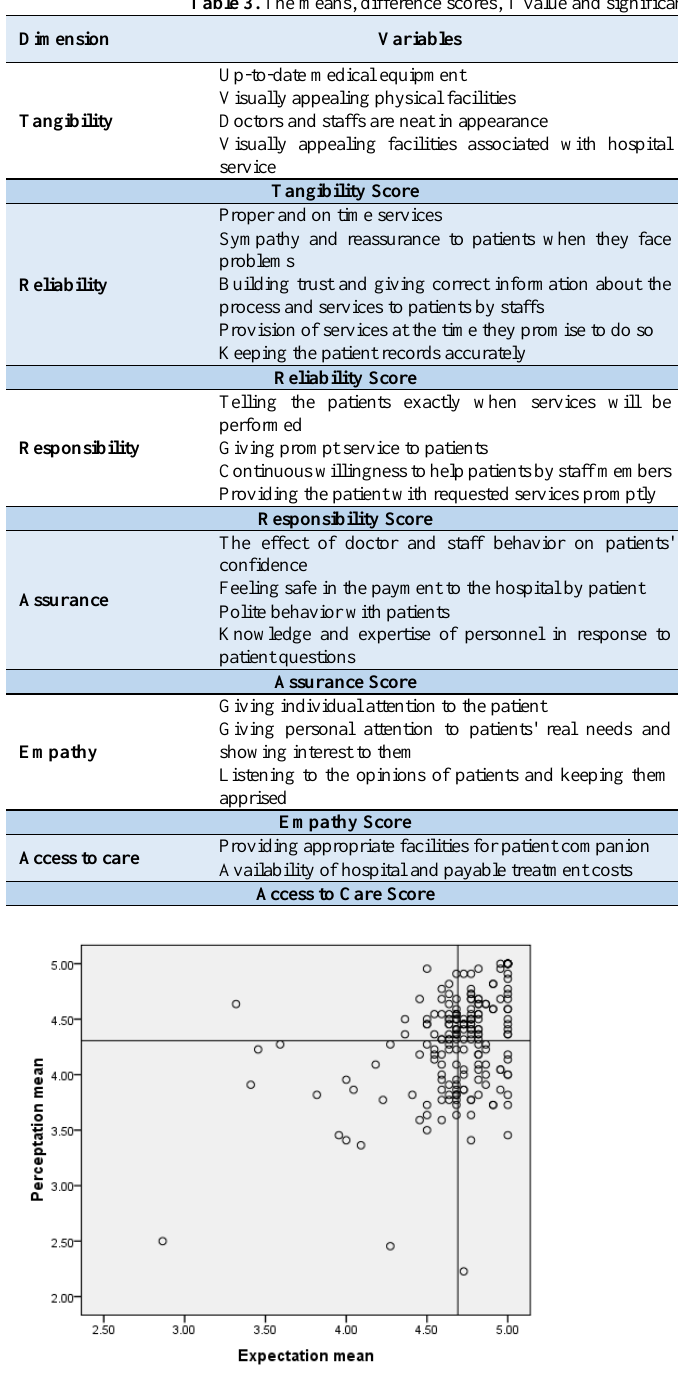
Table 3. The means, difference scores, T value and significance obtained through the evaluation of each question